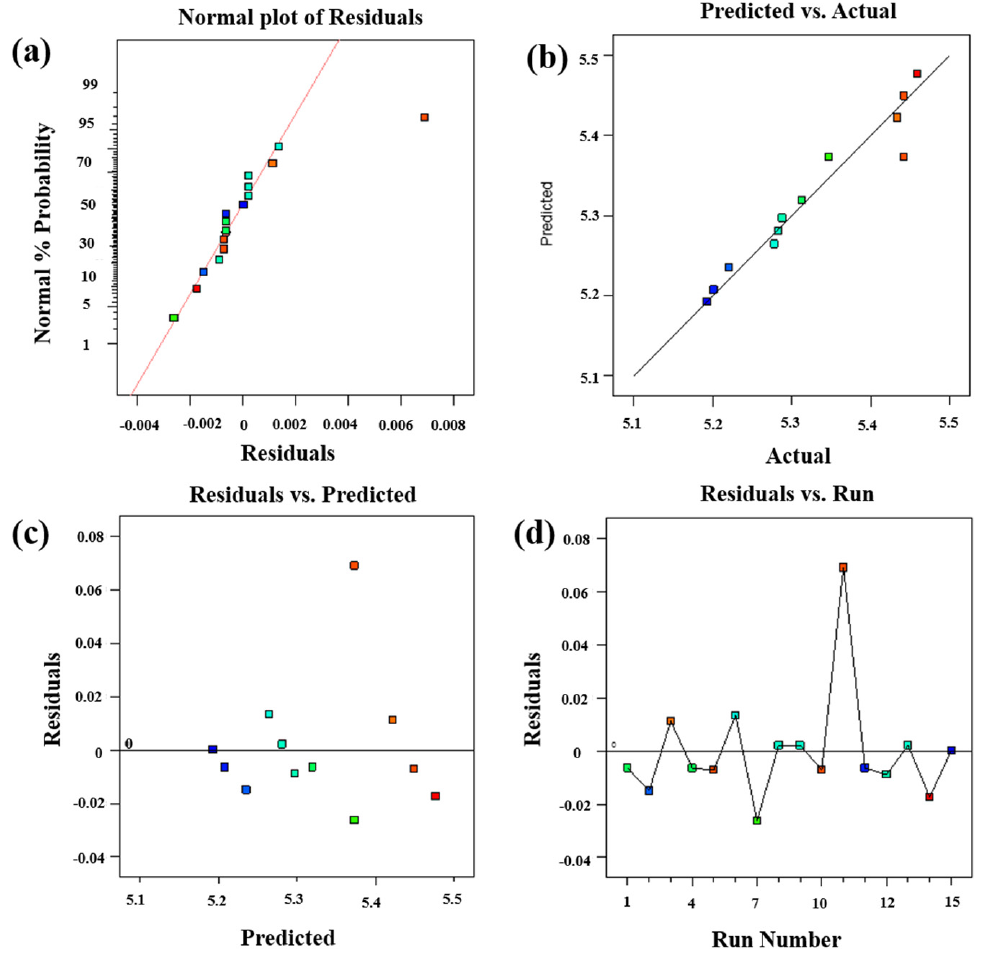
Figure 15. ( a ) Normal plot of residuals ( b ) predicted vs. actual plot ( c ) residuals vs. predicted plot ( d ) residuals vs. run plot.